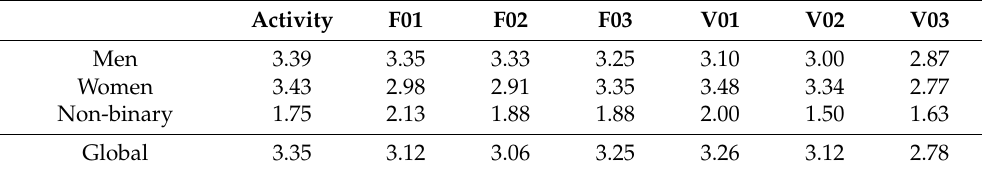
Table 5. Evaluation of the activity and the tests carried out according to gender.